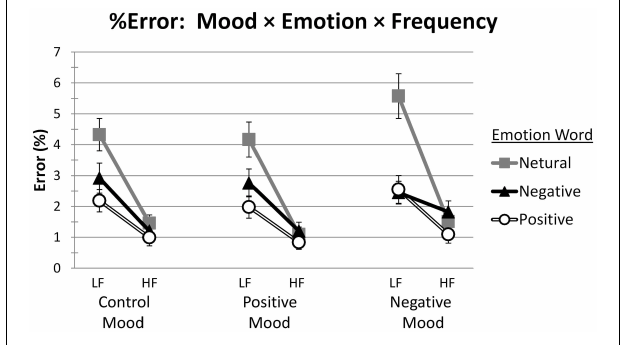
FIGURE 2 | Mean %Error, with SE bars, on words as a function of Mood (Control, Positive, Negative), Emotion (Positive, Negative, Neutral), and Frequency (LF, HF). LF, low frequency; HF, high frequency.